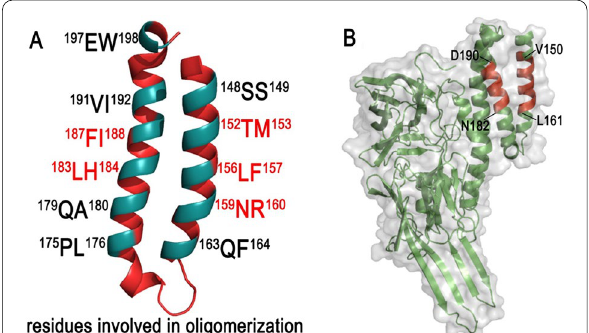
Fig. 1 The design and construction of alanine mutants of Cry2Ab site‑directed on the helices α4–α5. A Helices α4–α5 in Domain I of Cry2Ab. B The 3D structure of Cry2Ab activated‑toxin, proteolysis of Cry2Ab removed the first three α‑helices (helices α1–α3) and exposed the helices α4–α5 in Domain I. The region V 150 ‑R 160 in helix α4 and N 182 ‑D 190 in helix α5 were speculated involved in